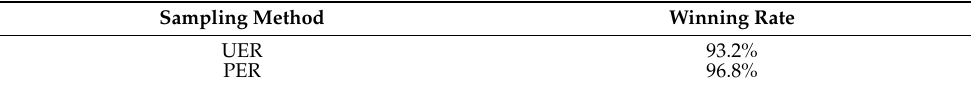
Table 9. The analysis of Monte-Carlo (MC) experiments for the trained results of UER-DDPG and